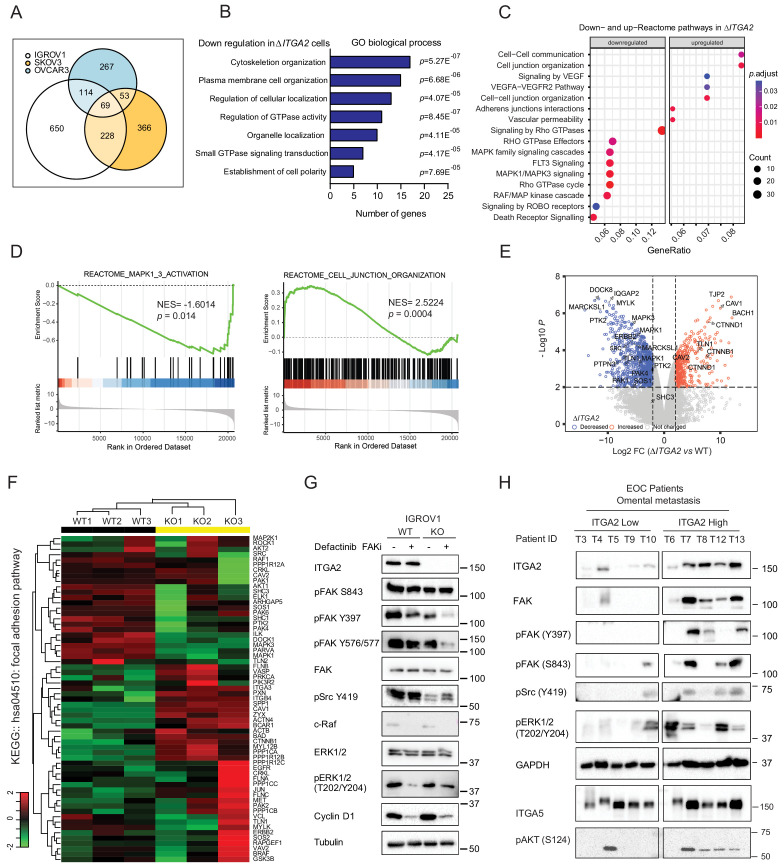
Identification of ITGA2-dependent activation of FAK and MAPK signaling axis using phosphoproteomics.(A) Venn-diagram highlights the number of significantly downregulated phosphoproteins shared among three ΔITGA2 ovarian cancer cell lines. (B) Top seven gene ontology (GO) biological process terms with highest statistical significance. The horizontal axis displays the number of genes in the intersection group of three ΔITGA2 ovarian cancer cell lines. (C) GSEA analysis identified up- or downregulated pathways in ΔITGA2 cells. The Cluster Profiler dot plot visualization shows enriched terms as dots. The highest ranking of the significantly enriched pathway is displayed. (D) Reactome pathway analysis of MAPK and cell junction organization pathway comparing ΔITGA2 with WT cells. NES = normalized enrichment score. Nominal p-value calculated by the permutation test in GSEA analysis. (E) Volcano plot shows differentially expressed phosphoproteins between WT and ΔITGA2 cells. y-axis defines the statistical significance -Log10p<2 and x-axis defines the magnitude of Log2-fold change >2 or < −2. Colored circle defines significantly decreased (blue) or increased (red) phosphopeptides in ΔITGA2 cells. (F) Heatmap analysis of KEGG hsa04510:focal adhesion pathway phosphoproteins. Data were analyzed based on three biological replicates of IGROV1 WT and ΔITGA2 cells. (G) Western blot analysis shows major change of phosphoproteins in the focal adhesion signaling upon treatment of 5 μM Defactinib for 24 hr. (H) Western blot analysis shows induced activation and phosphorylation of FAK/Src/MAPK signaling in patient-derived ITGA2high compared to ITGA2low omental tumor (n = 10).
Figure 7—source data 1.Analysis of phosphoproteomics in IGROV1, SKOV3, and OVCAR3 WT versus ΔITGA2 cell lines.